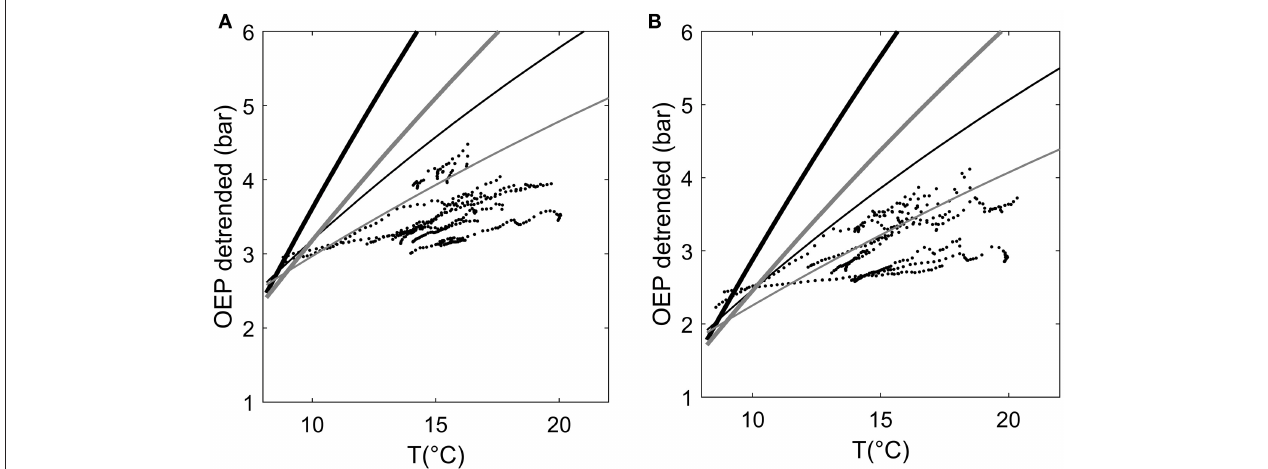
FIGURE 6 | 10-min averages of de-trended oleoresin exudation pressure (OEP) (decreasing trend removed by subtracting running 5-day average) in two Scots pines as a function of ambient temperature during morning and afternoon hours (from 6:00 to 14:00), August 4–16 2017. (A) stem top of Tree1 and (B) stem top of Tree 3. Lines present the OEP that could be expected based only on the thermal expansion and gas solubility of resin. Black lines represent a model scenario with high CO 2 content in resin (8% of total gases) and gray lines a scenario with small CO 2 content (2%). Thick lines represent a model scenario where the elastic modulus of a resin duct is 10 MPa, and thin lines a scenario where the elastic modulus is 5